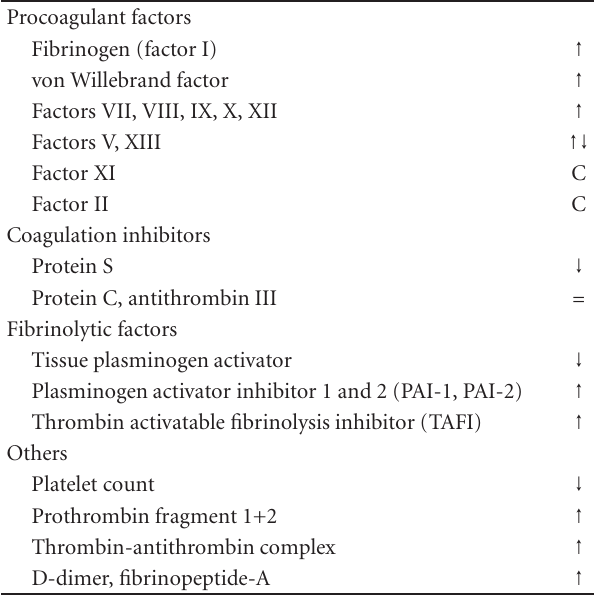
Table 1: Modifications of haemostatic factors during pregnancy. Procoagulant